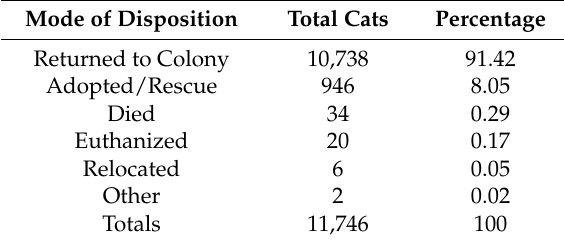
Table 1. Disposition of cats in the Albuquerque CCP.